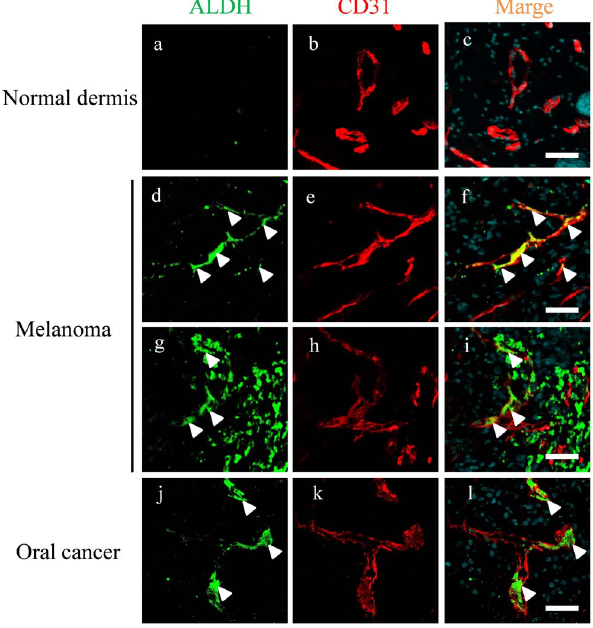
Figure 5. ALDH is expressed in mouse tumor blood vessels in vivo. Double immunofluorescence staining for endothelial markers CD31 and ALDH in normal mouse tissue (dermis) (a–c), A375SM melanoma xenografts () (d–i), and oral carcinoma xenografts (j–l). Merged images (white arrow) show co-localization of ALDH (green) and CD31 (red) in situ. Nuclei were counterstained with DAPI. Scale bar: 40 m